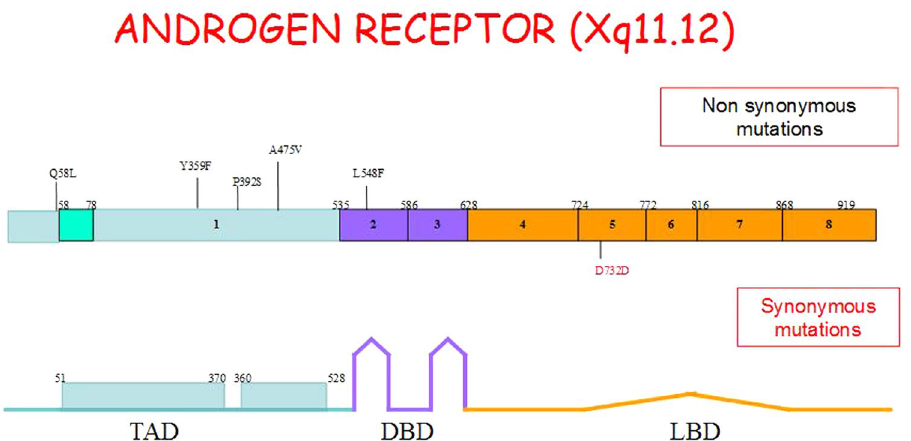
Figure 1. In the upper part of the figure are show the 8 exons of the Androgen Receptor gene with the position of each gene mutation found in our study (missense mutations in black, synonymous mutation in red). The lower part of the figure indicating the correspondence between exon and AR protein domains: exon1 coding for TAD (transactivation domain), exons 2 and 3 coding for DBD (DNA binding domain), exon 4–8 coding for LBD (ligand binding